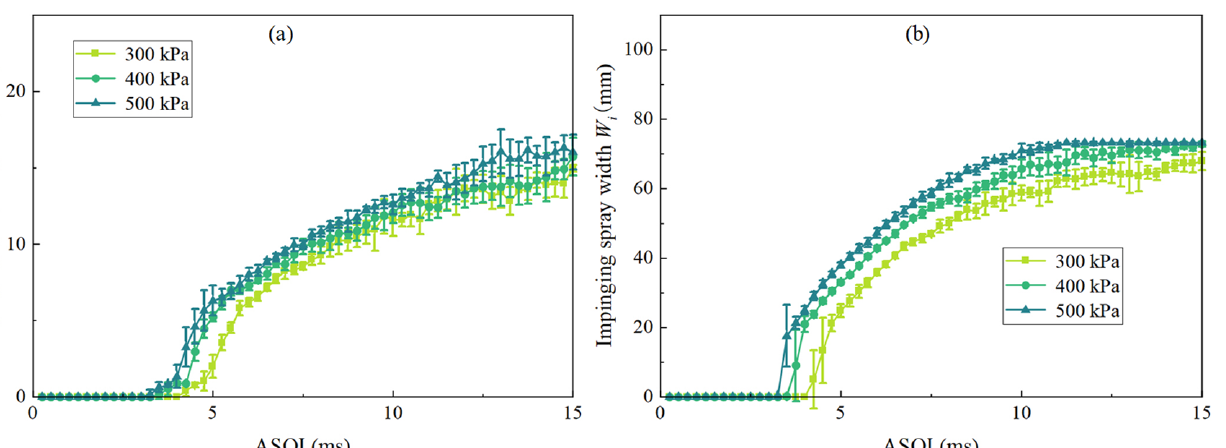
where K i was the contribution index in parameter i under boundary conditions; C 1 and C were the area between the curves of parameters (like H i ) and abscissa axis, which were obtained by integral. Among them, C represented the integral value obtained under the boundary conditions. Thus, if K i is greater than 100%, this indicates that parameters can be increased by changed boundary